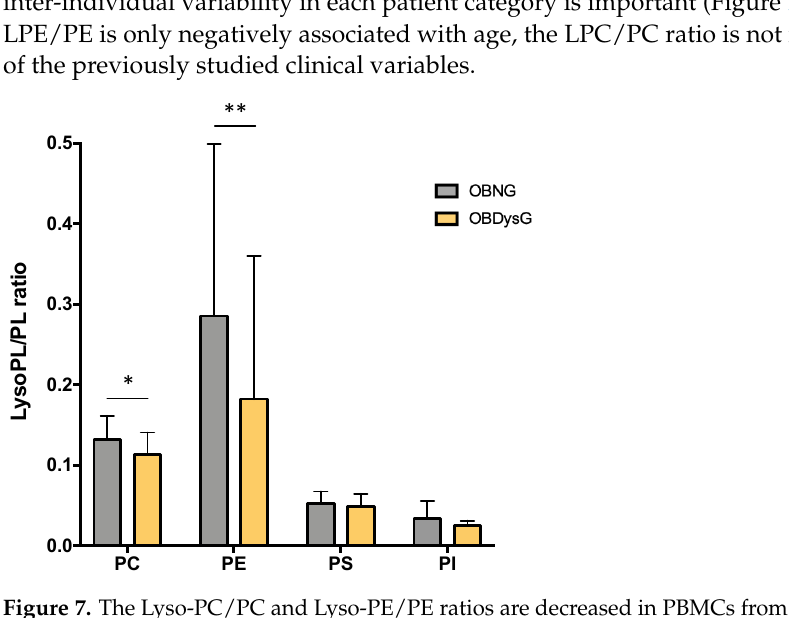
Figure 7. The Lyso-PC/PC and Lyso-PE/PE ratios are decreased in PBMCs from OBDysG compared to OBNG patients. Data are mean ± SD. Mann–Whitney-Wilcoxon Test was performed on data. OBNG ( n = 18) and OBDysG ( n = 25). * p < 0.05; ** p < 0.01.